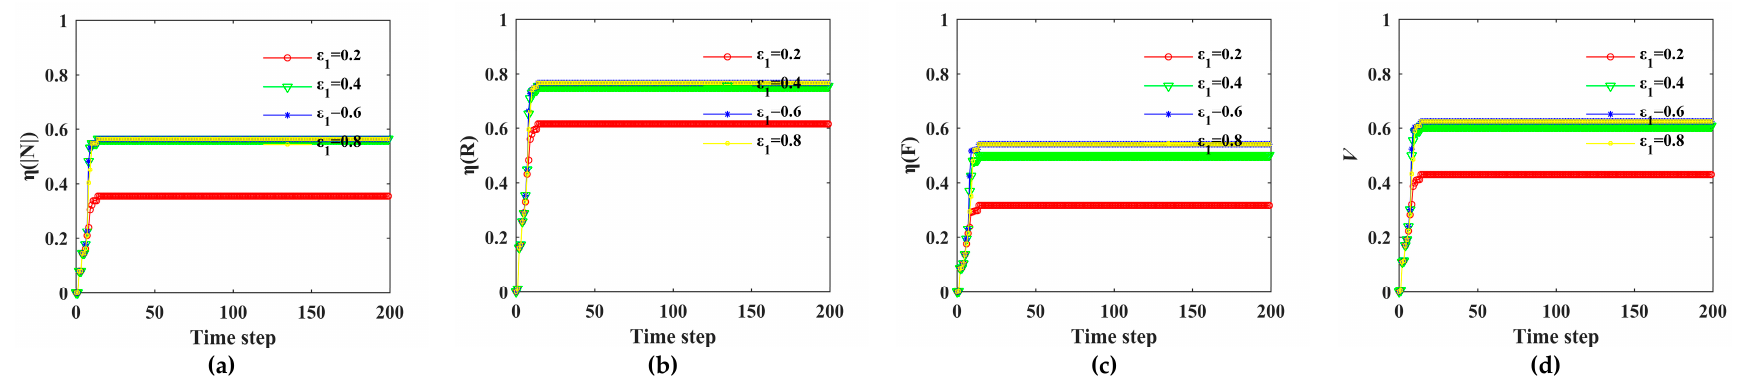
Figure 9. Cascading failures of Bus–Metro CBN under different capacity tolerances. (a) – (c) show the loss ratio of node scale in the maximum connected subgraph, the network efficiency and the passenger flow with time under different capacity tolerances, respectively. (d) shows the change of network vulnerability with time under different capacity tolerances. Note: In these scenarios, s = 1.0, ε = 0.2,